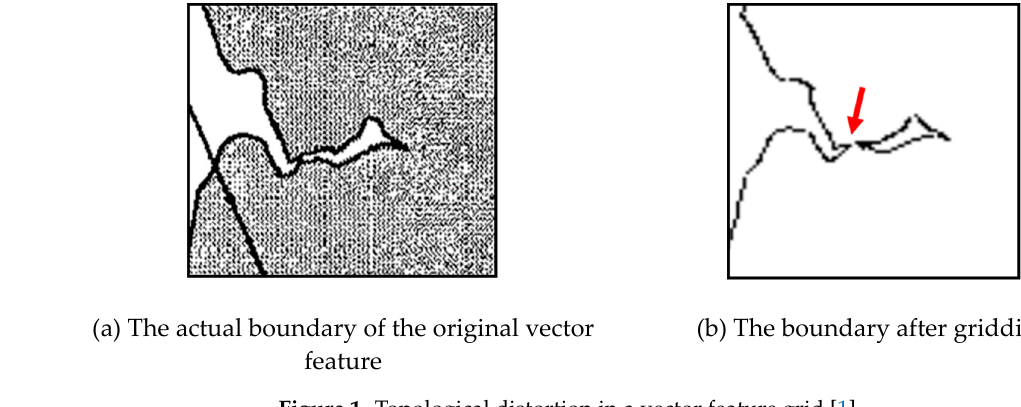
Figure 1. Topological distortion in a vector feature grid [1].